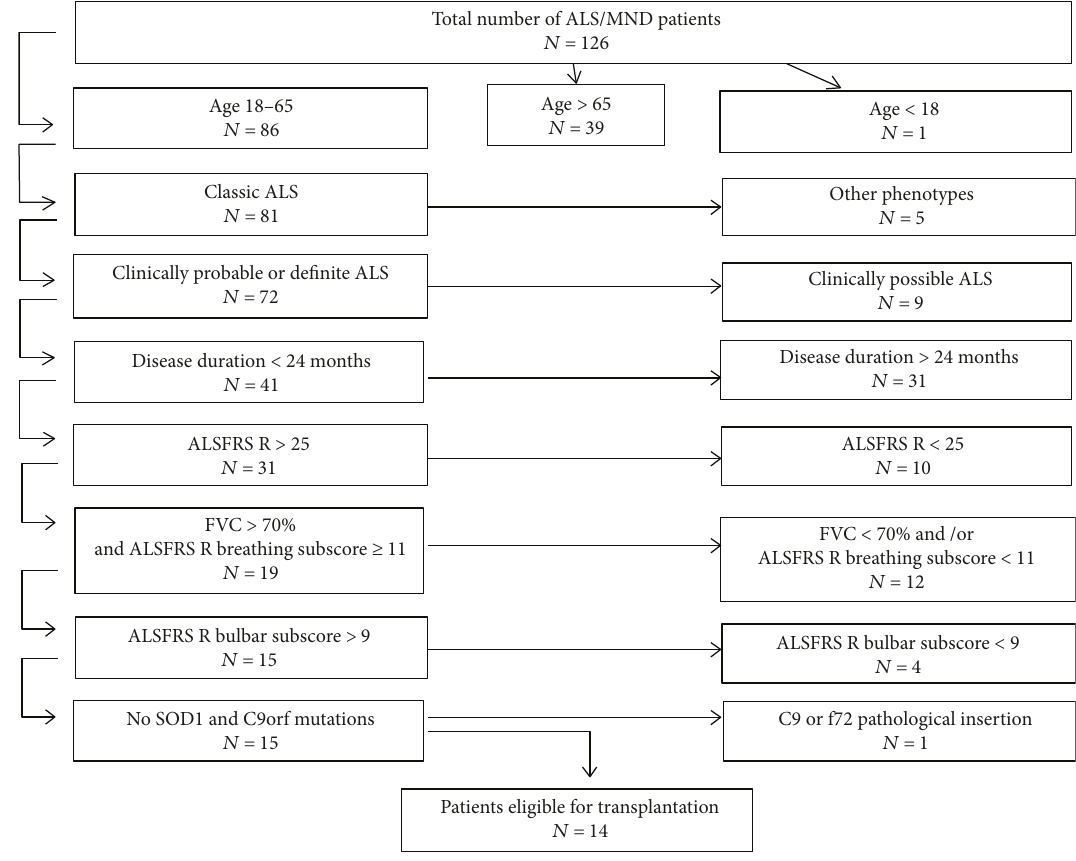
Figure 3: The quali fi cation scheme of patients according to the proposal during the International Workshop on Progress in Stem Cells Research for ALS/MND in